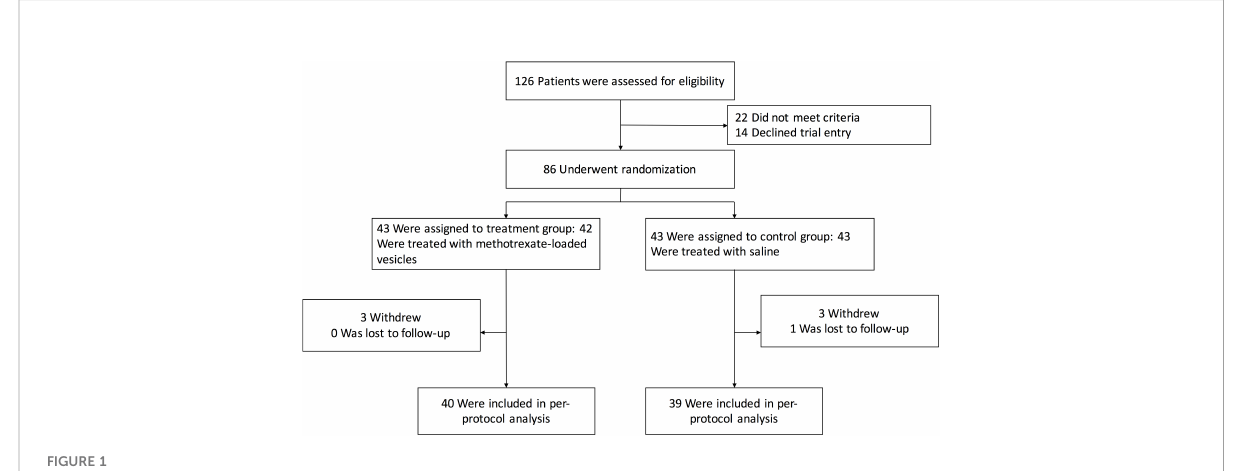
FIGURE 1 Trial pro fi